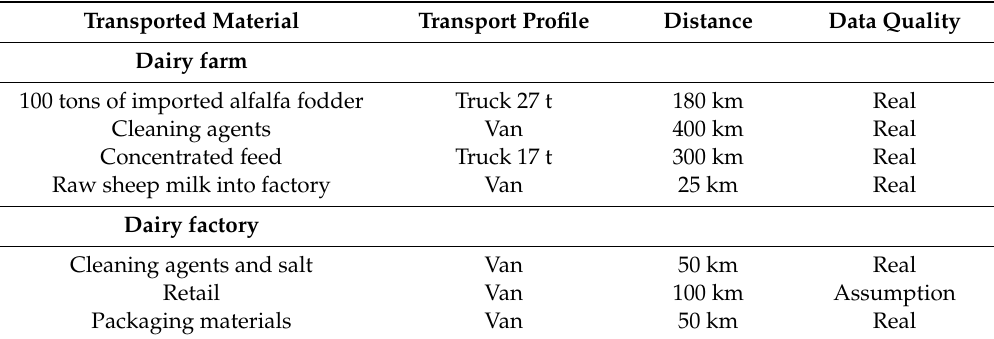
Table 3. Transportation related data associated with the dairy farm and cheese factory.